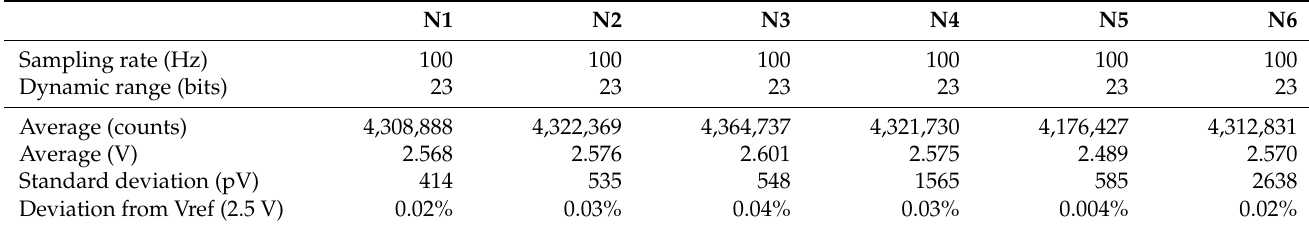
Table 3. Internal noise and deviation from the reference voltage.